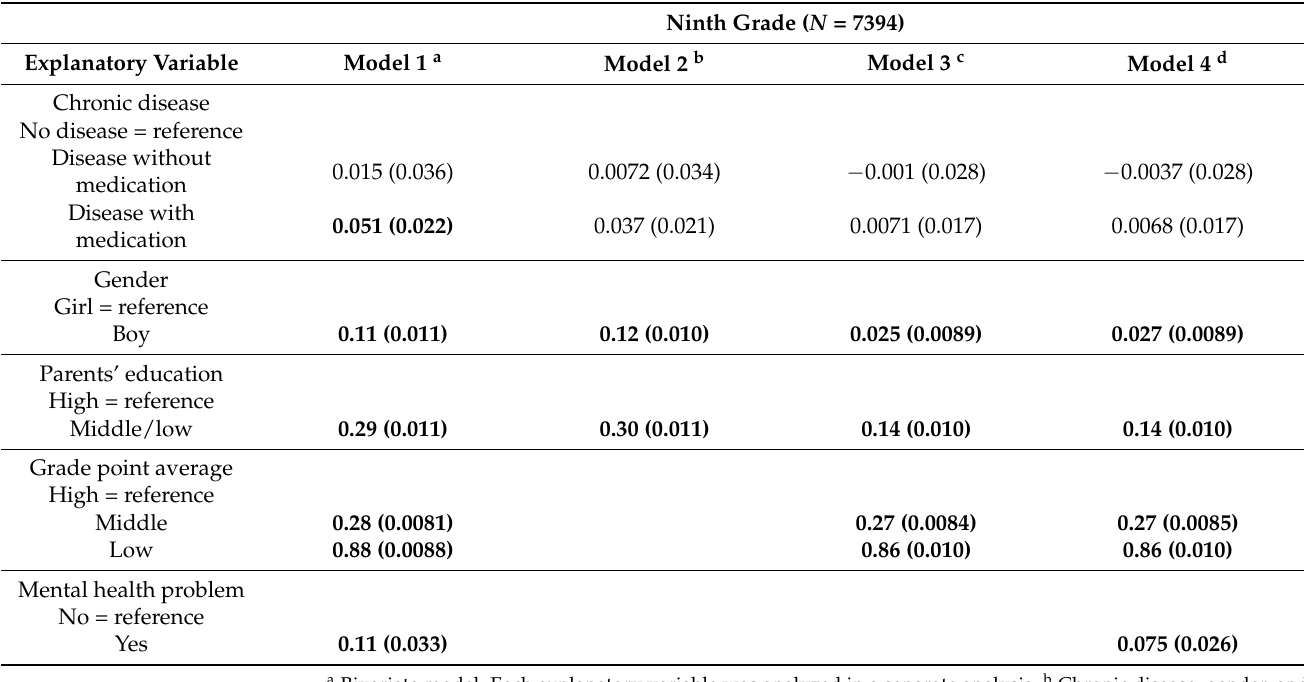
Table A5. Ending up at a non-academic upper-secondary school: the analyses of the logistic models of Table 3 presented as average marginal effects. Standard deviations in parentheses.